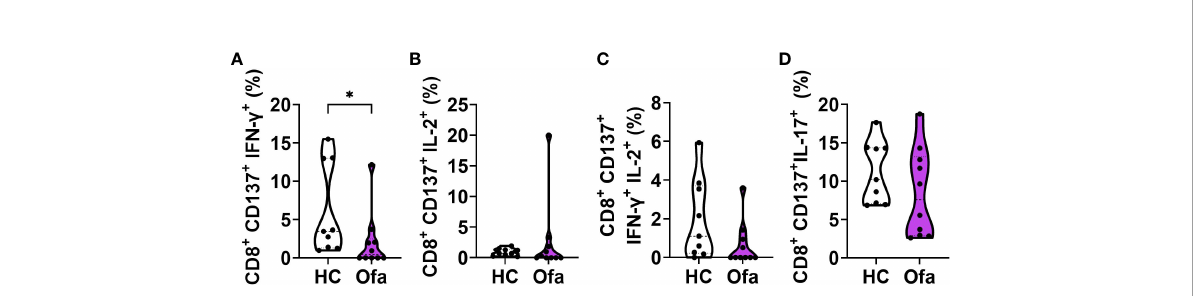
FIGURE 6 Ofa treated MS patients express lower response of IFN- g + and IFN- g + IL-2 + in cytotoxic T cells. Peripheral blood mononuclear cells (PBMCs) of ofatumumab treated MS patients (Ofa) and healthy controls (HC) were collected 4-13 weeks following third vaccination against SARS-CoV-2 and restimulated with a SARS-CoV-2 peptide pool following immunophenotyping via FACS. (A) Frequencies of IFN- g + cytotoxic T cells and (C) IFN- g /IL-2 double positive cytotoxic T cells were signi fi cantly lower in the Ofa group compared to HC. Expression of (B) IL-2 + cells and (D) IL- 17 + cytotoxic T cells did not differ. Data were analyzed with a two-tailed Mann-Whitney U test. n=10 Ofa, n=9 HC.